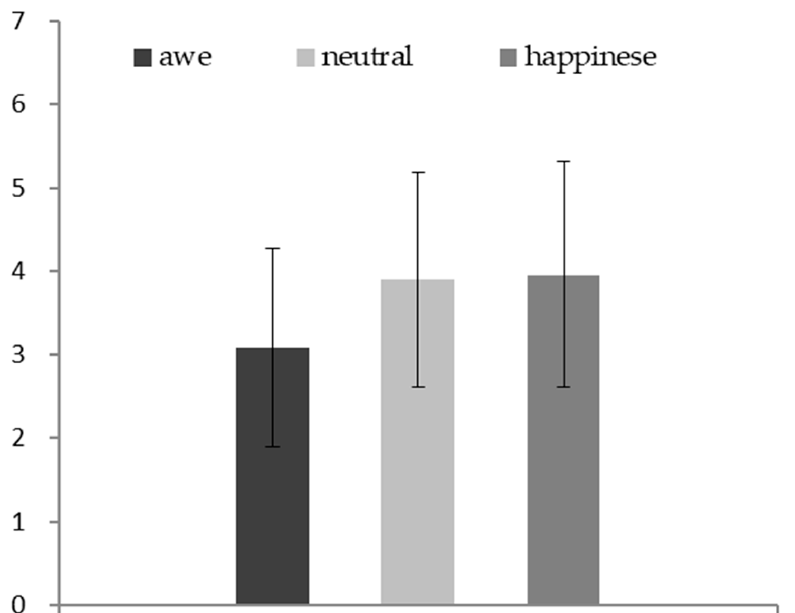
Figure 2. The effect of awe (vs. neutral vs. happiness) on negative emotions arising from self-threat.